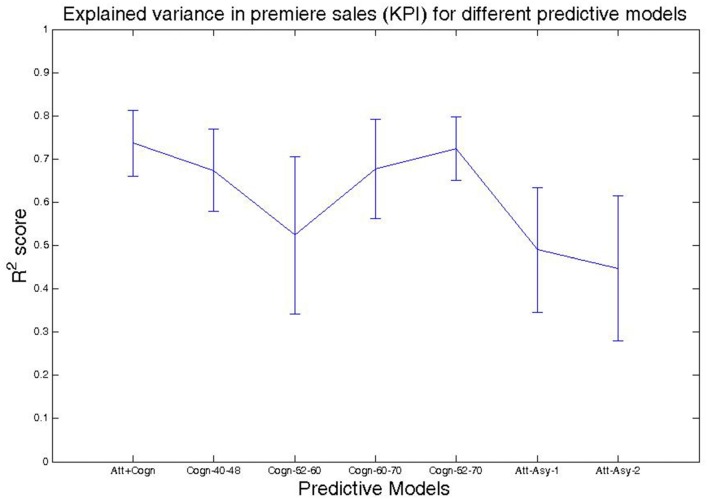
Shows the R2 score obtained by each of the seven models when predicting the sales performance (KPI) on a movie’s premiere. The error bars show the SE of R2 scores calculated using the bootstrap method.